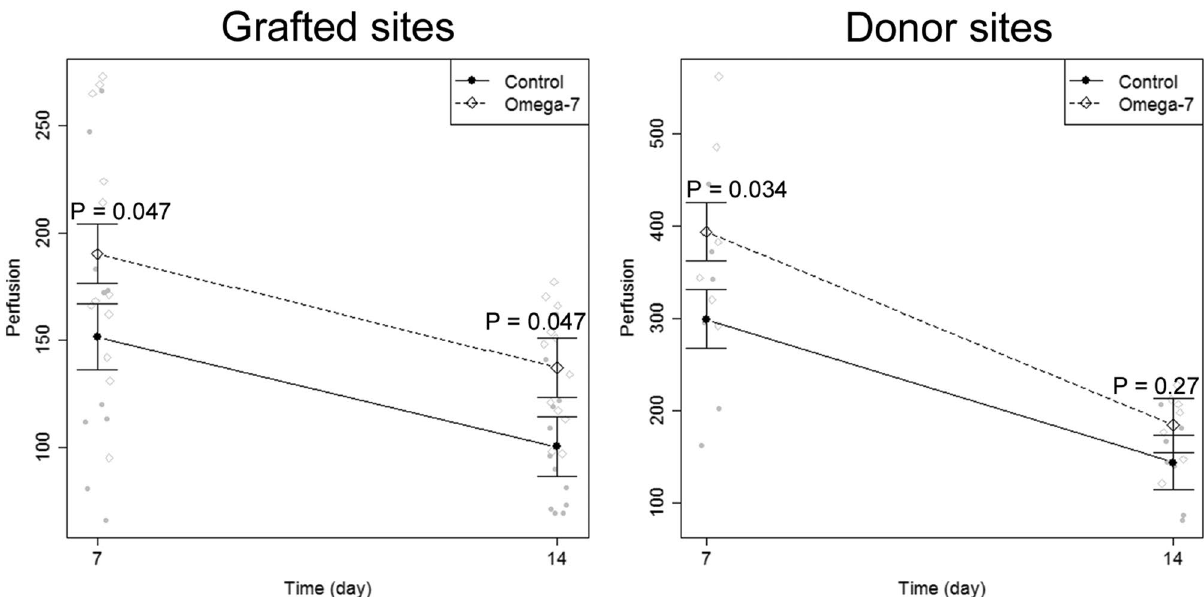
Figure 5. Blood flow of grafted burn and donor sites at 7 and 14 days. Blood flow was measured in six sheep (12 treated and 12 control sites) at grafted sites, and in seven sheep (7 treated and 7 control sites) at donor sites. Left panel: Blood flow in grafted burn wound sites. Right panel: Blood flow in donor sites. Data are expressed as mean ± SEM.